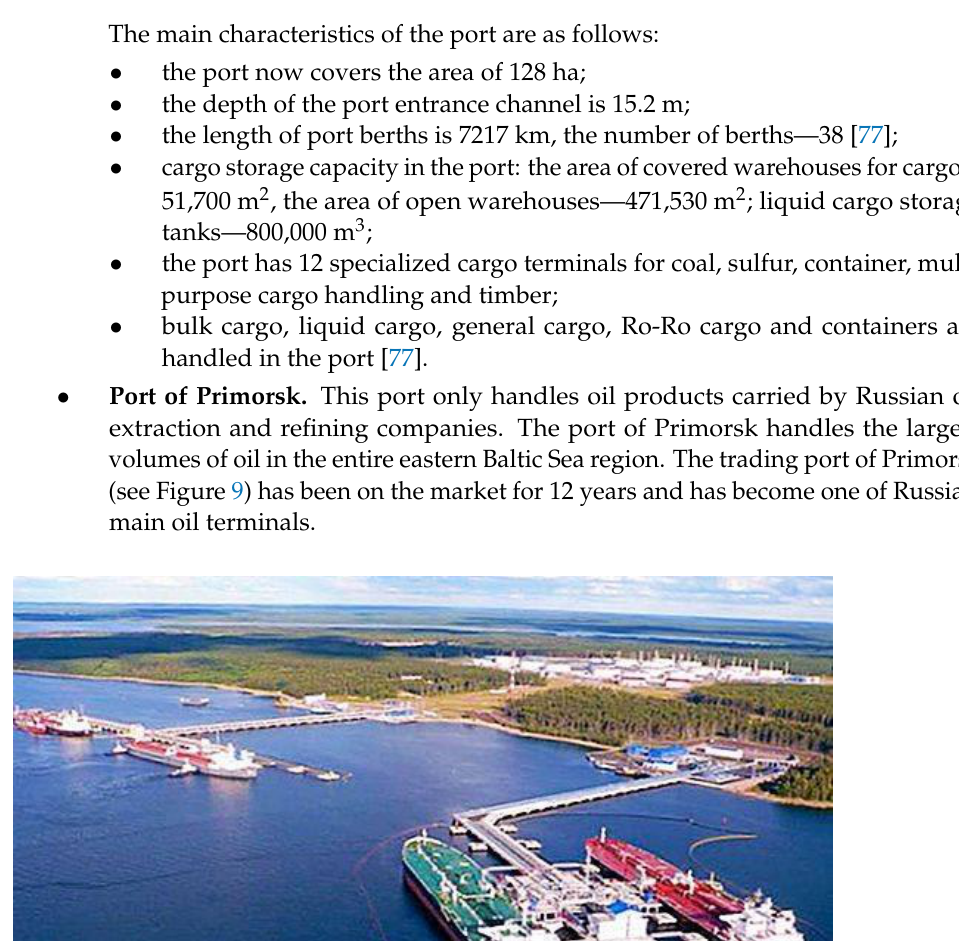
Figure 10. Port of St. Petersburg. Source: [80]. The main characteristics of the port are as follows: •